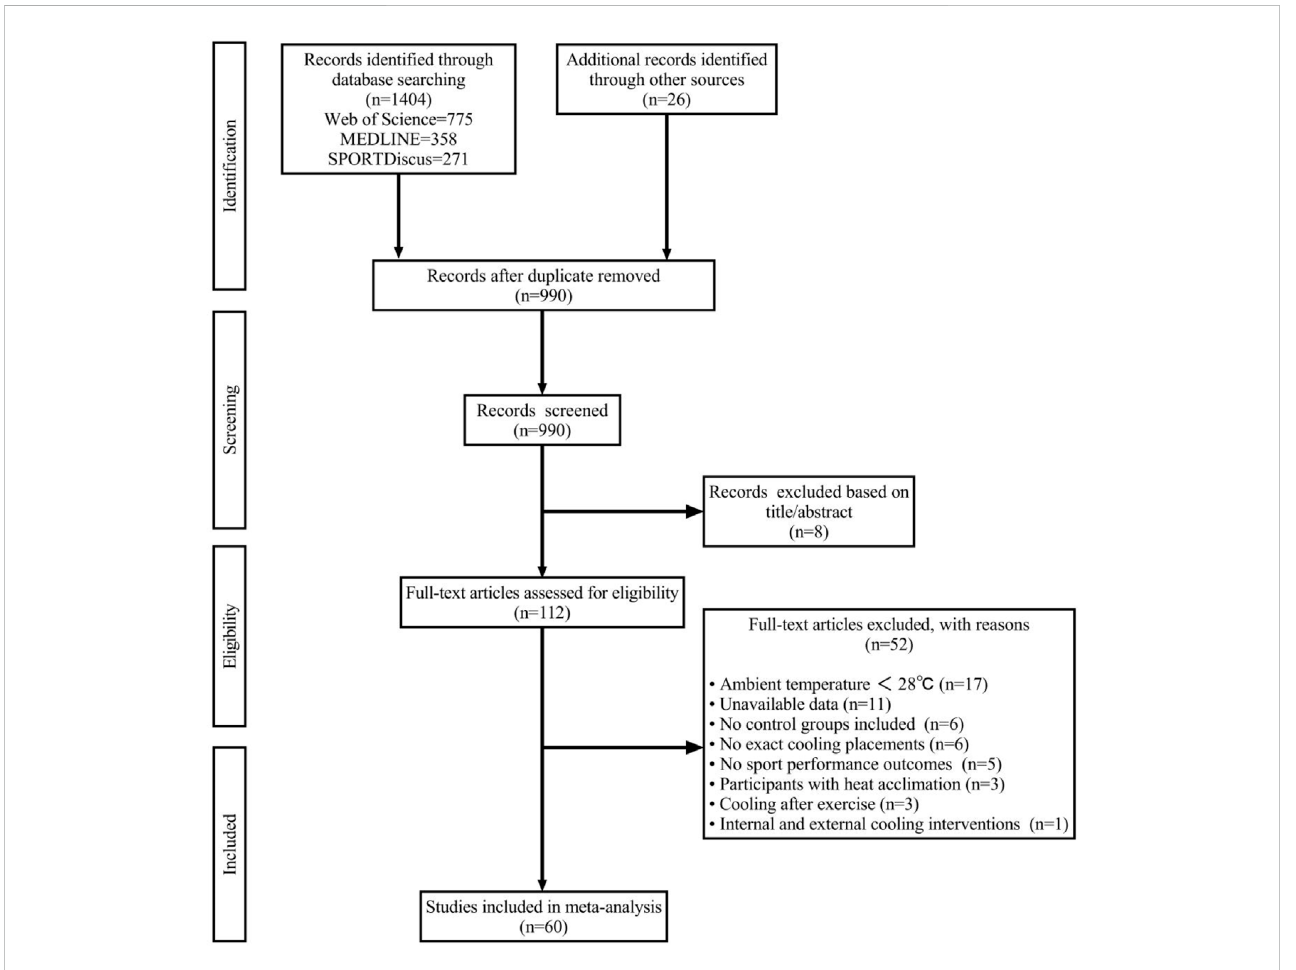
FIGURE 1 Overview of selection process of the included studies for this meta-analysis.